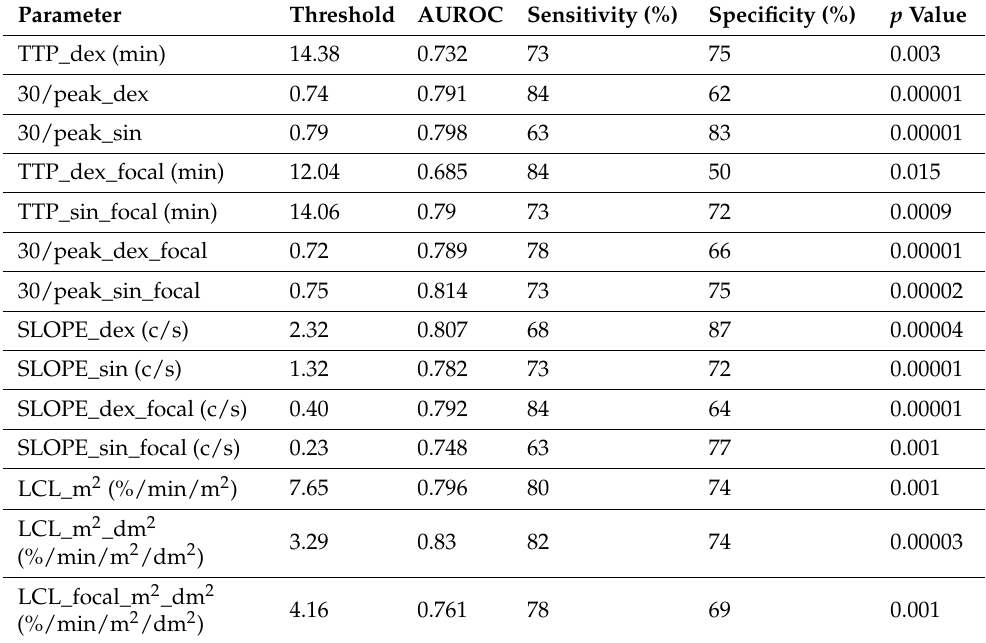
Table 4. Dynamic scintigraphic quantitative parameters separating insignificant and significant